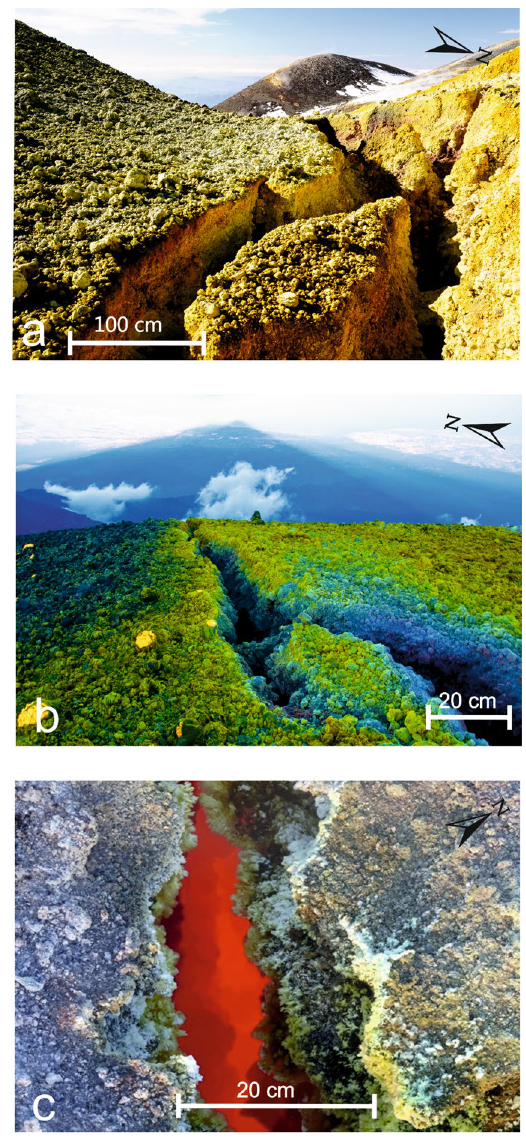
Figure 2. ( a ) Photo of the fractures field on the northern ridge of the SEC, the average width of the fractures was about 1 m, totally fumarolized and covered with sulphate sublimates that produce a bright yellow colour (photo taken on 1 November 2014); ( b ) photo of the fractures on the eastern ridge of the SEC summit; ( c ) incandescent fracture on the eastern ridge of the SEC (photo taken on 15 November 2014). Photos taken by C.